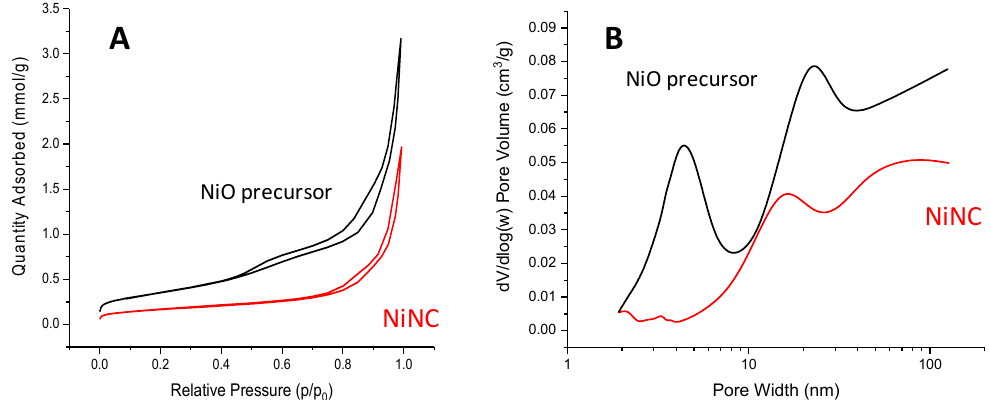
Figure 4. Adsorption-desorption isotherms ( A ) and pore distribution ( B ) of both the NiO precursor and the NiNC catalyst.